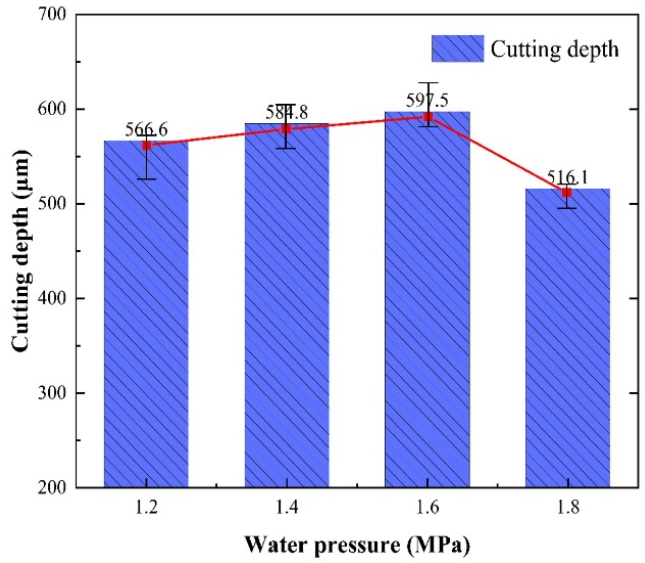
Figure 10. Average cutting depth at the different water pressures.